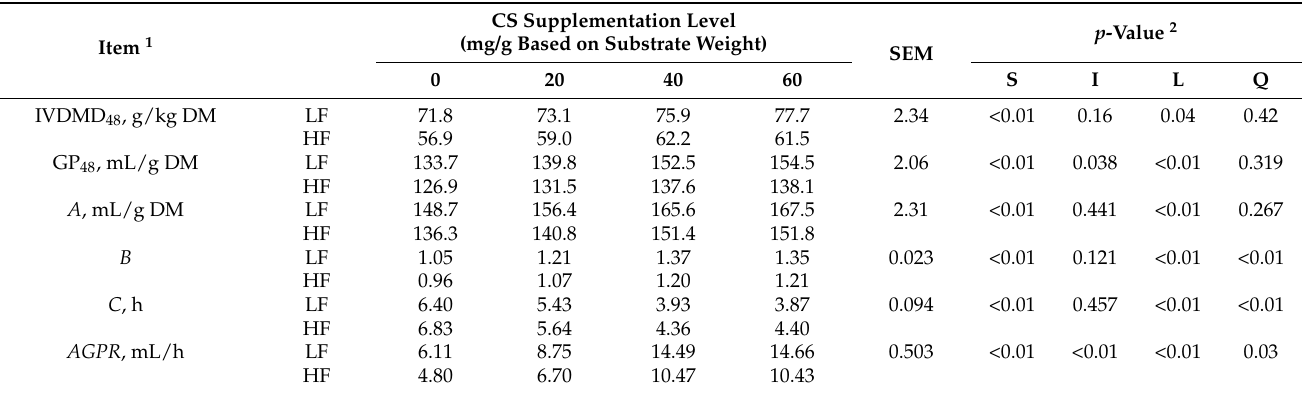
Table 2. In vitro dry matter disappearance and gas production kinetic parameters at 48 h of culture fluids under two substrates and different CS supplementation